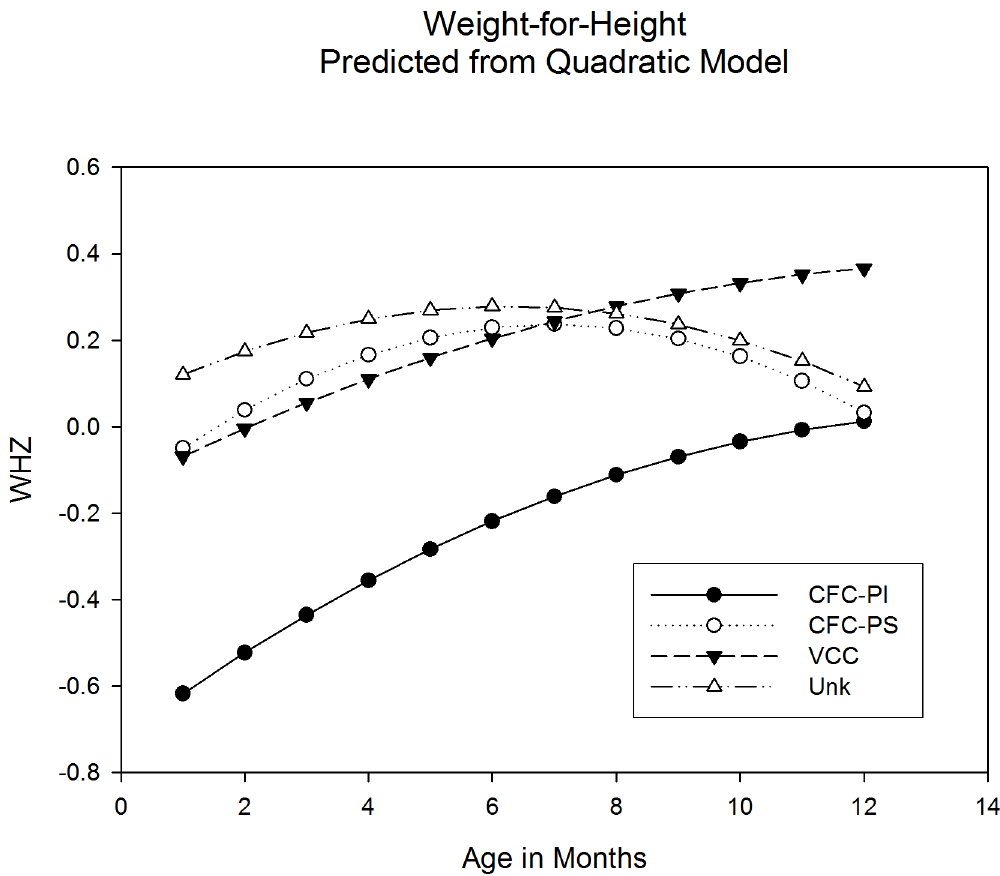
Fig 2. Weight for height over the first twelve months of life. Study subgroups: CF-C-PI = CF-causing group, pancreatic insufficient; CF-C-PS = CF-causing group, pancreatic sufficient; VCC = mutations of varying clinical consequence group; and Unk = mutation of unknown liability group. Pancreatic insufficient subjects were removed from VCC (n = 3) and Unk (n = 16) groups for this analysis. There was a statistically significant difference between CF-C-PI and CF-C-PS (p = 0.0247), VCC (p = 0.0013), and Unk (p < 0.0001). There is no statistically significance difference between CF-C-PS and VCC and Unk (respectively p = 0.9767 and p = 0.9922). Pairwise comparisons indicate a significant difference of WHZ between CF-C-PI and CF-C-PS, VCC, and Unk at 1m (p < 0.0001) and at 6 months (p = 0.0003), and no statistically significant difference at 12 months (p = 0.177), suggesting nutritional recovery in the CF-C-PI